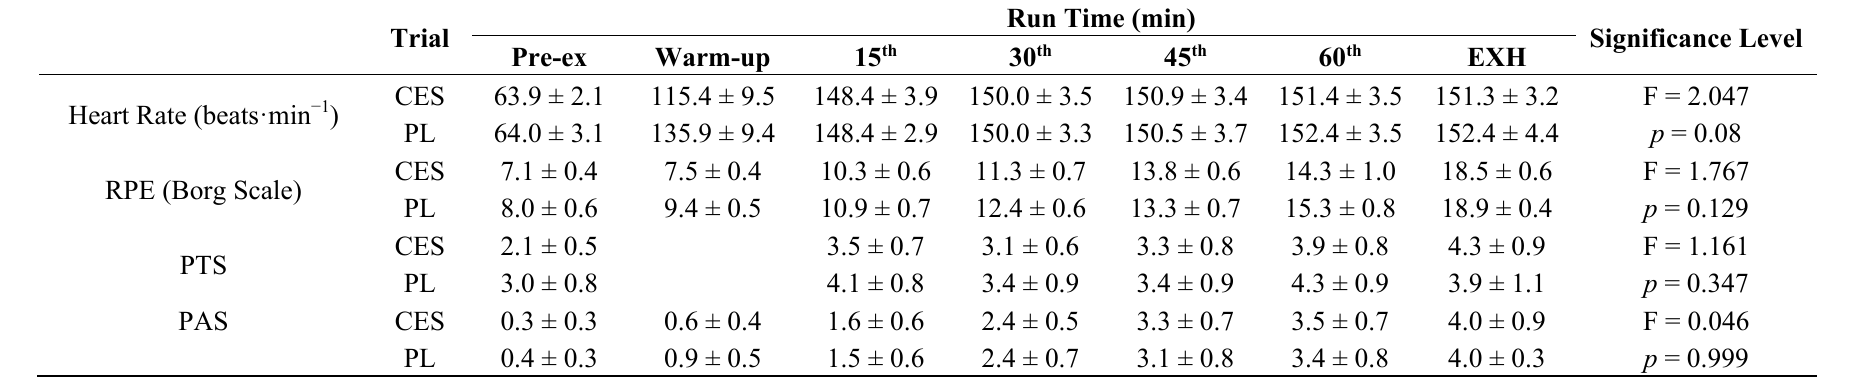
Table 1. Summary of the heart rate, rate of perceived exertion (RPE), perceived thirst scale (PTS) and perceived abdominal discomfort scale (PAS) during running in the carbohydrate-electrolyte solution (CES) and placebo (PL) trials, values are presented as mean ±